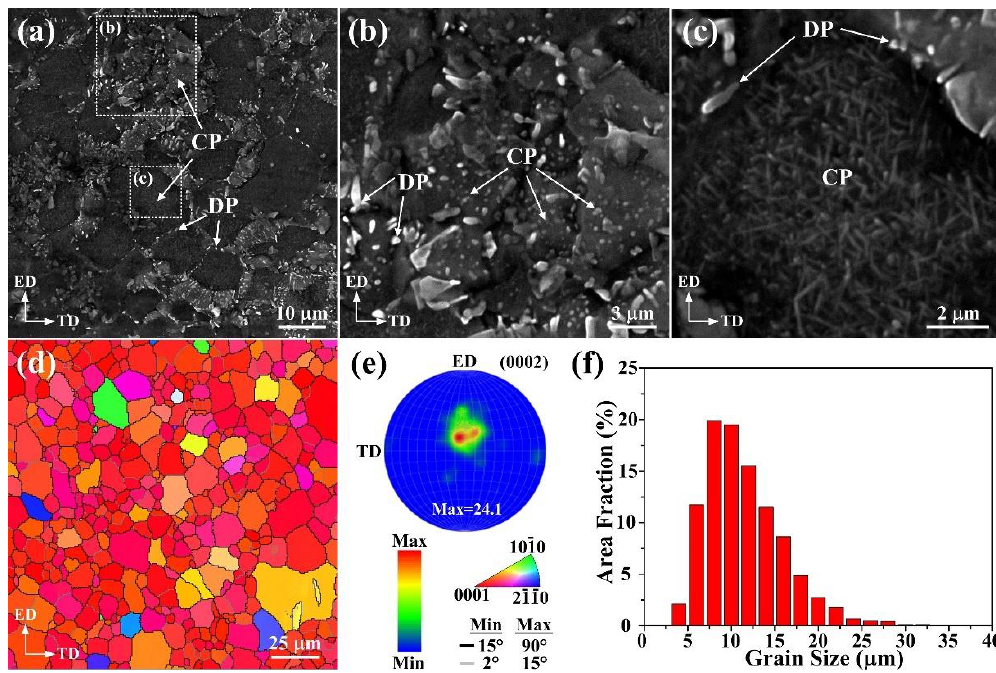
Figure 4. ( a ) Low magnification, ( b , c ) high magnification SEM micrographs (CP: continuous precipitation, DP: discontinuous precipitation), ( d ) EBSD IPF map, ( e ) (0002) pole figure and ( f ) grain size distribution of DA-54h.